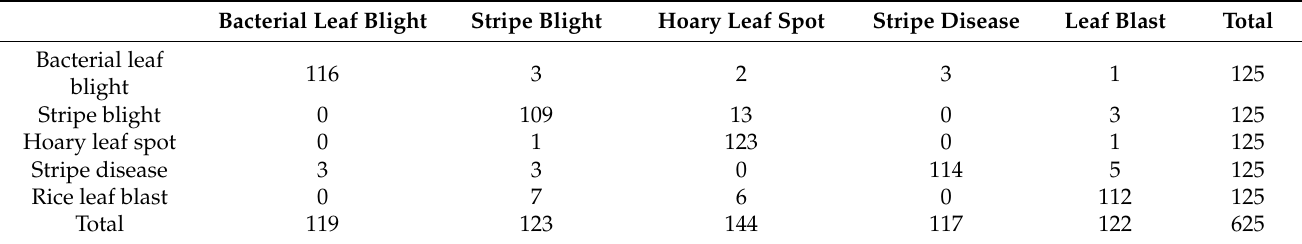
Table 3. Confusion matrix of RlpNet network